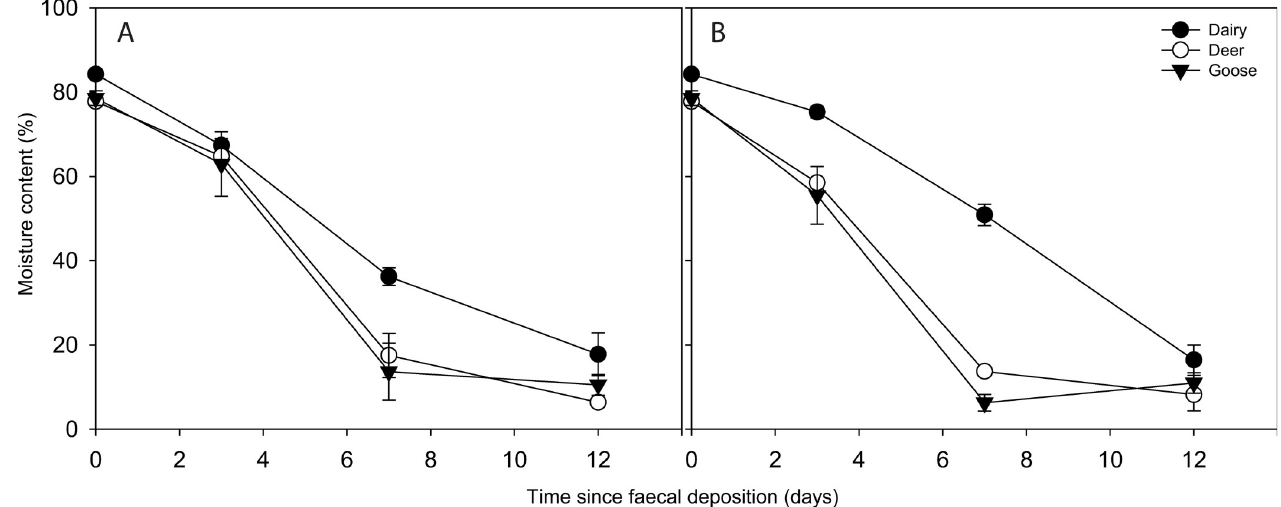
Fig 5. Change in moisture content of faeces over time when held at a constant 15˚C (A) and 0˚C (B). Data points are the mean of five replicates ± standard error.